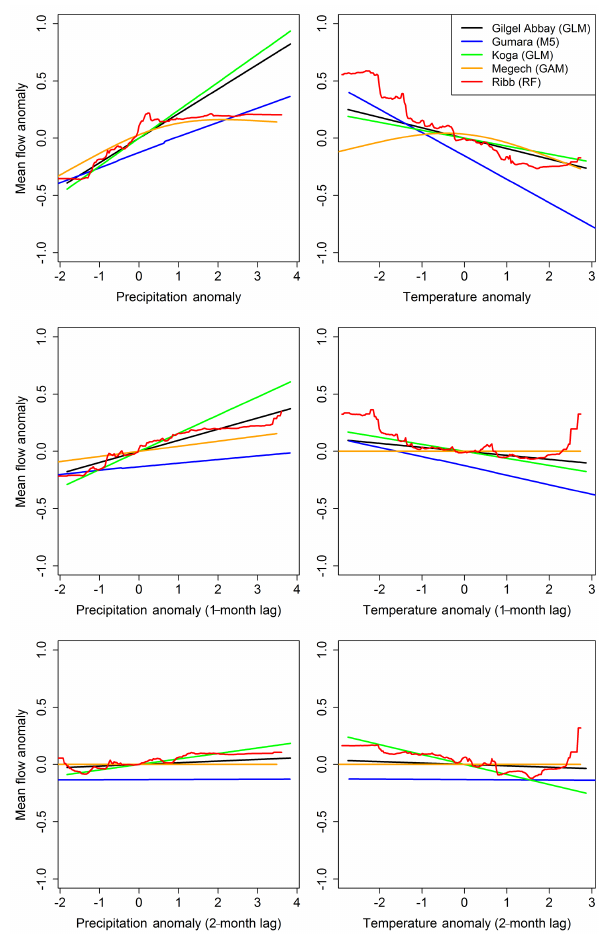
Figure 6. Partial dependence plots for climate covariates in the highest performing model in each basin. Model type is indicated in parentheses.